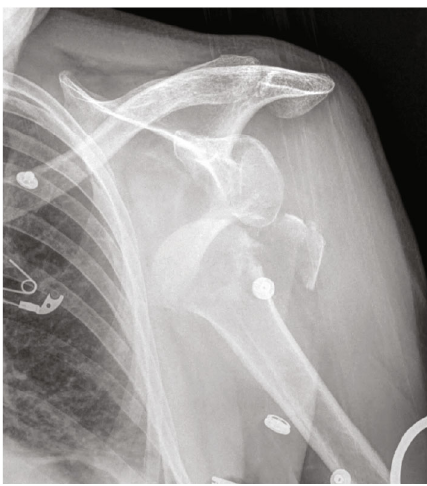
Figure 1: Four-part fracture of the left proximal humerus. A plain radiograph of the left shoulder taken in the anteroposterior (AP) direction at presentation showing a displaced, four-part fracture of the proximal humerus with involvement of the surgical neck and greater and lesser tuberosities.